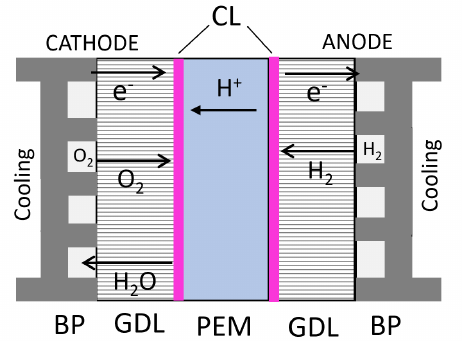
Figure 12. Fuel cell membrane electrolyte assembly (MEA) comprising of bipolar plates (BP) with cooling channels; gas diffusion layer (GDL); catalyst layer (CL); and proton exchange membrane (PEM) along with corresponding ion transport mechanism [193].